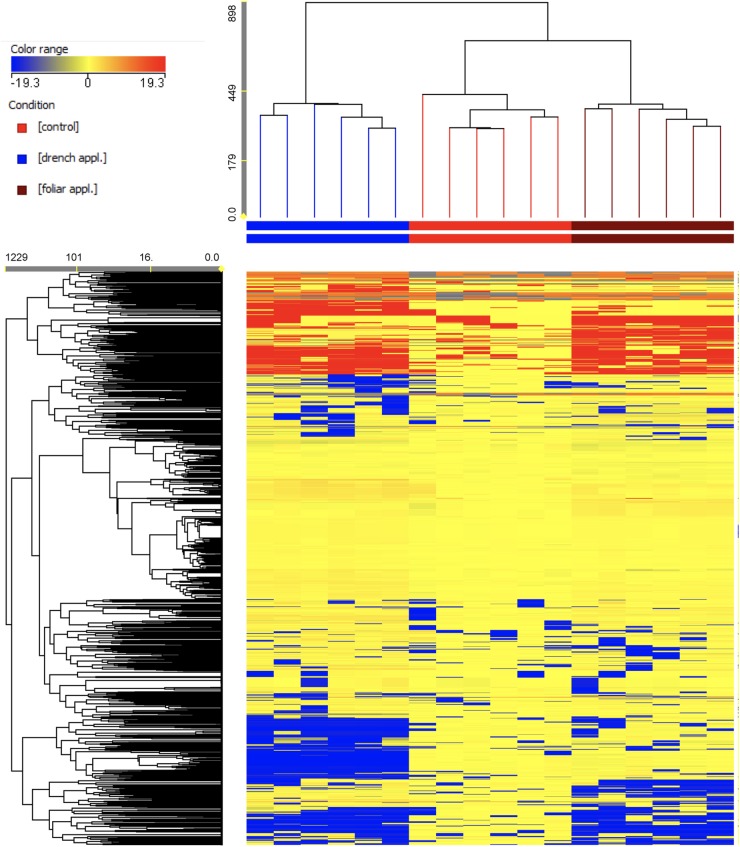
Unsupervised hierarchical cluster analysis (Euclidean similarity; linkage rule: Ward’s) carried out from metabolite profiles in tomato leaves from protein hydrolysate treated or untreated plants, as gained from UHPLC liquid chromatograph coupled to a quadrupole-time-of-flight mass spectrometer (UHPLC/QTOF-MS) untargeted metabolomics. Compound intensity was used to produce fold-change-based heat maps, based on which clustering was done.